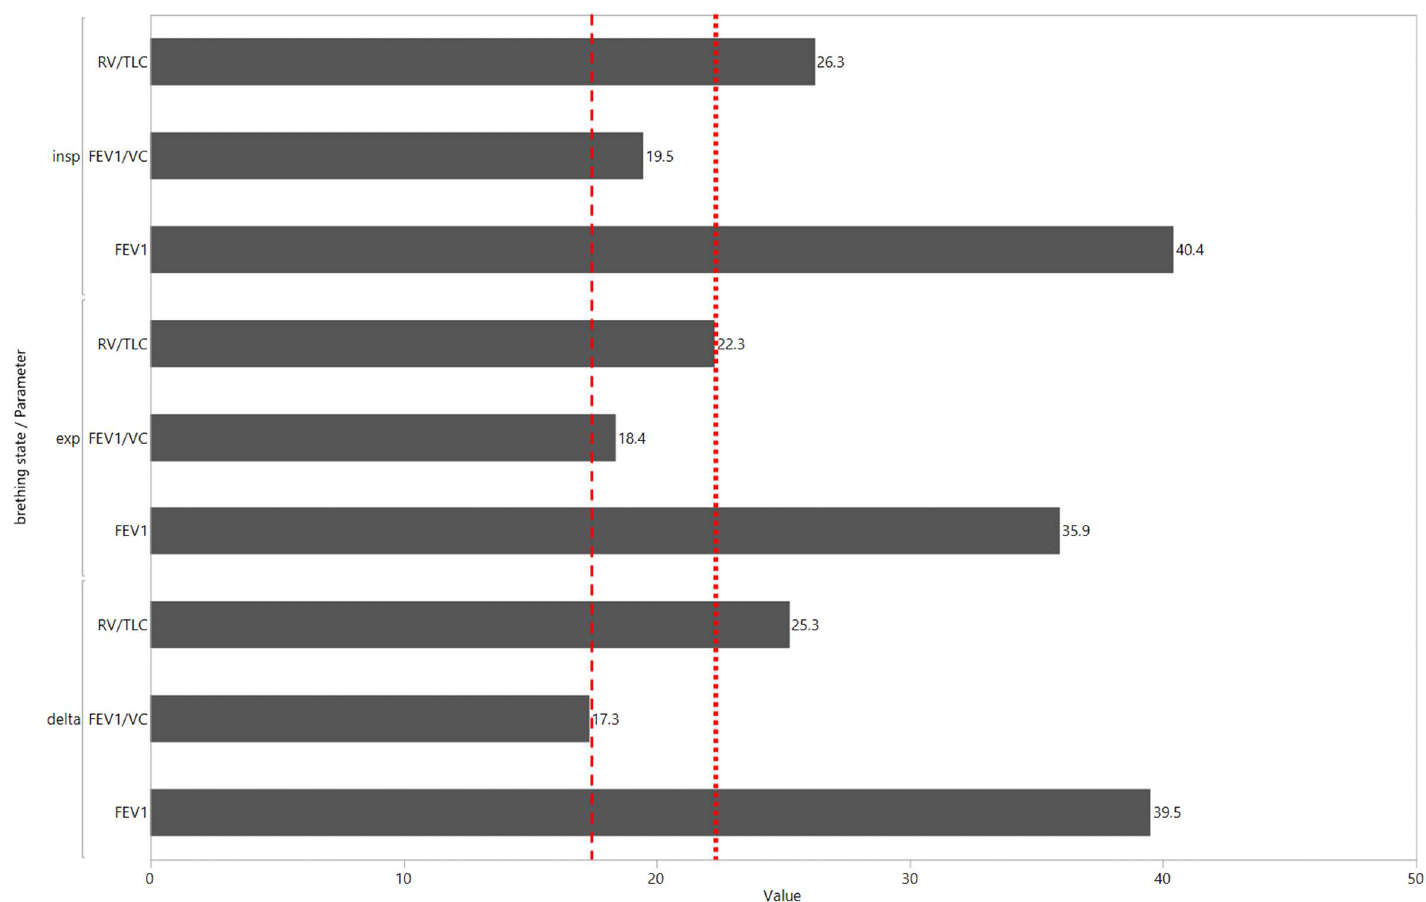
Figure 2. Mean relative errors of the polynomial regression for all datasets (inspiration, expiration, delta) and predicted parameters. The dotted and dashed line mark the distinct differences in prediction performance with regard to the expiration and delta scan for the FEV1/VC and RV/TLC, respectively.